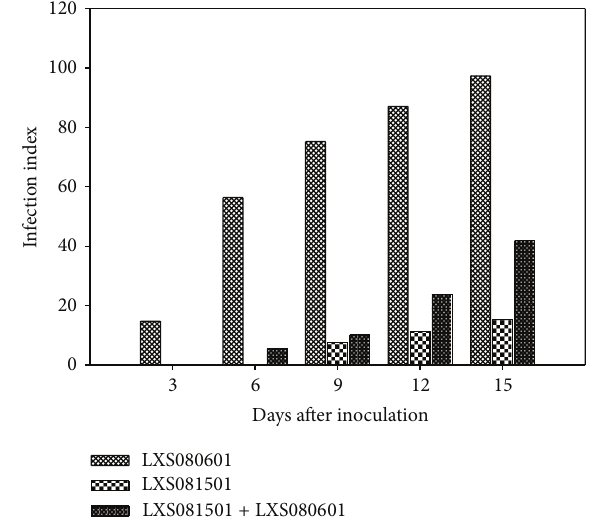
Figure 1: Induction of resistance in apple calli against the virulent Vmm strain LXS080601 by preinoculation with the attenuated Vmm strain LXS081501. Each column represents the average values of “Fuji” and “Gala” cultivars. Experiments included 30 calli per treatment and were repeated twice with three